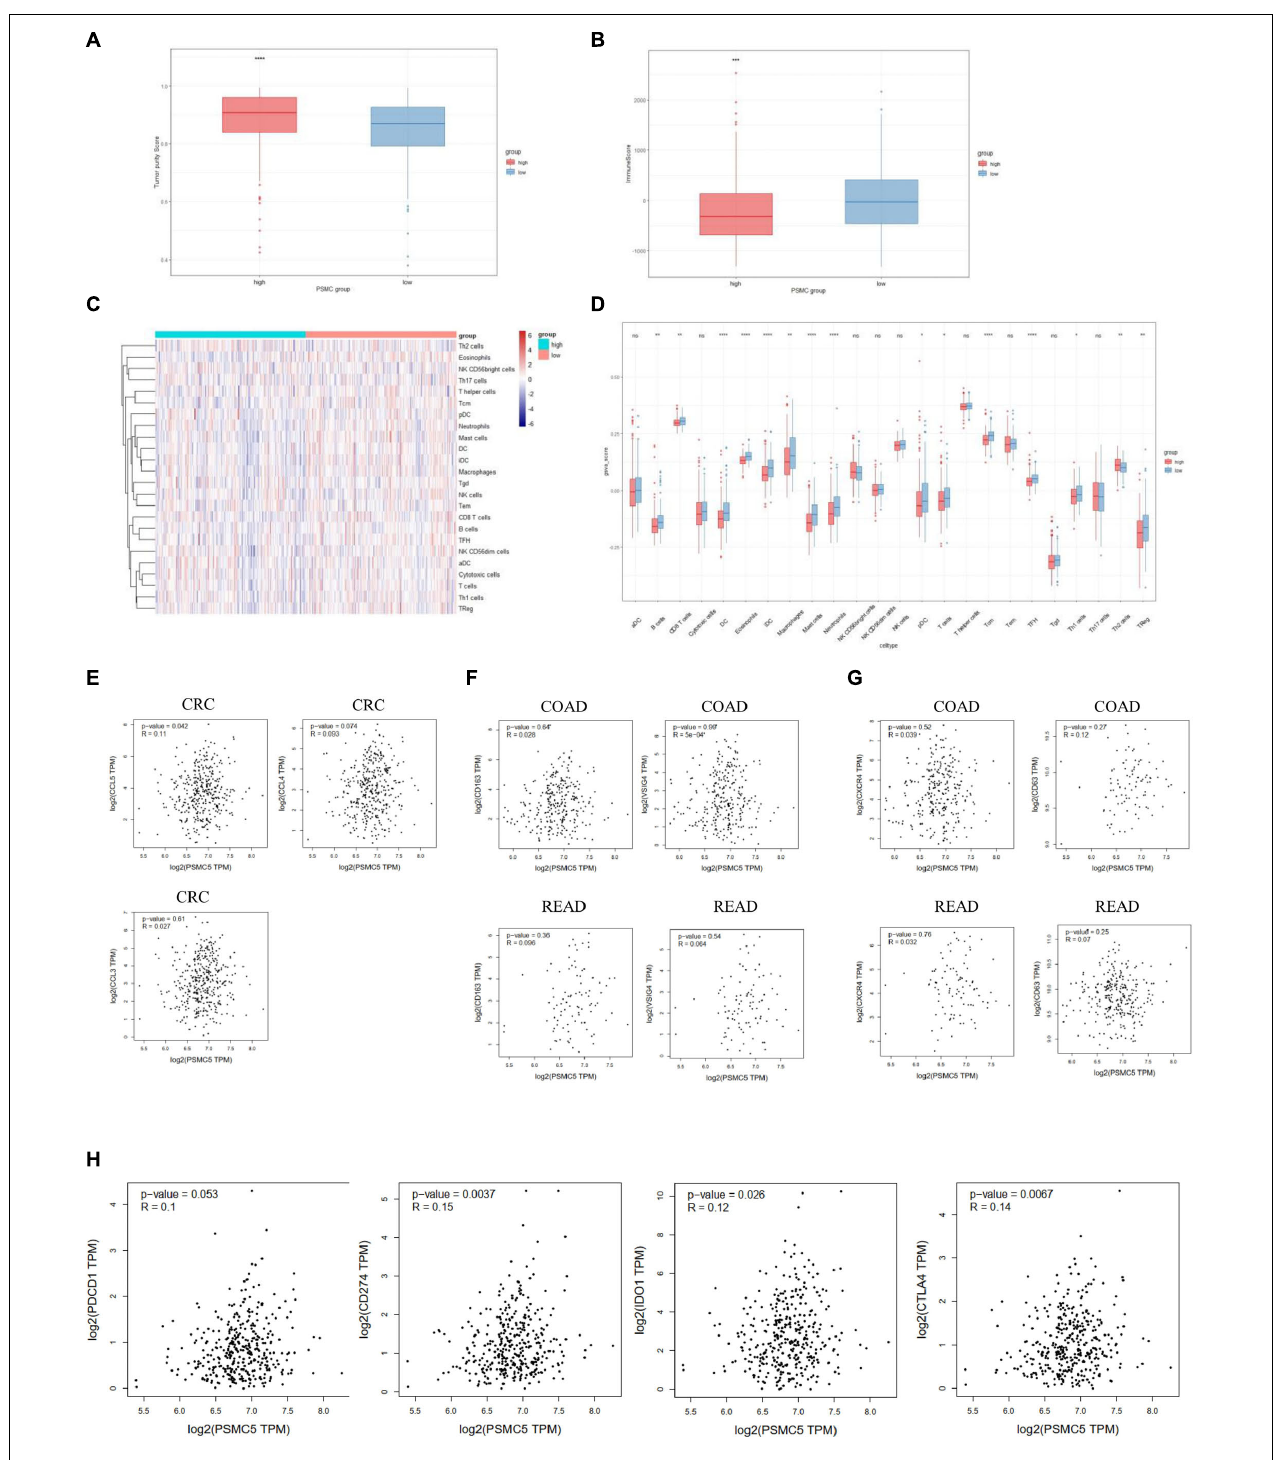
FIGURE 6 | PSMC5 modulated several immune infiltrating cells in the tumor microenvironments. (A,B) Score of tumor purity (A) and immune cells (B) between PSMC-high and PSMC-low group. p value was generated from Wilcoxon’s test. ** p < 0.01. (C) Heatmap showing the landscape of immune infiltrating cells of colorectal cancer. (D) Boxplot showing the difference of 24 kinds of immune cells between PSMC5-high and PSMC5-low groups. The significance of difference was calculated by Wilcoxon’s test. Ns, not significant. * p < 0.05, ** p < 0.01, *** p < 0.001, and **** p < 0.0001. (E–H) Correlation analysis between PSMC5 and several chemokines ( E ; CXCL5 and CXCL8), M2 macrophages ( F ; CD163 and VSIG4), N2 neutrophils ( G ; CXCR4 and CD63), and immune modulators ( H ; PDCD1, CD274, IDO1, and CTLA-4). R and p value were determined by Pearson’s correlation test.